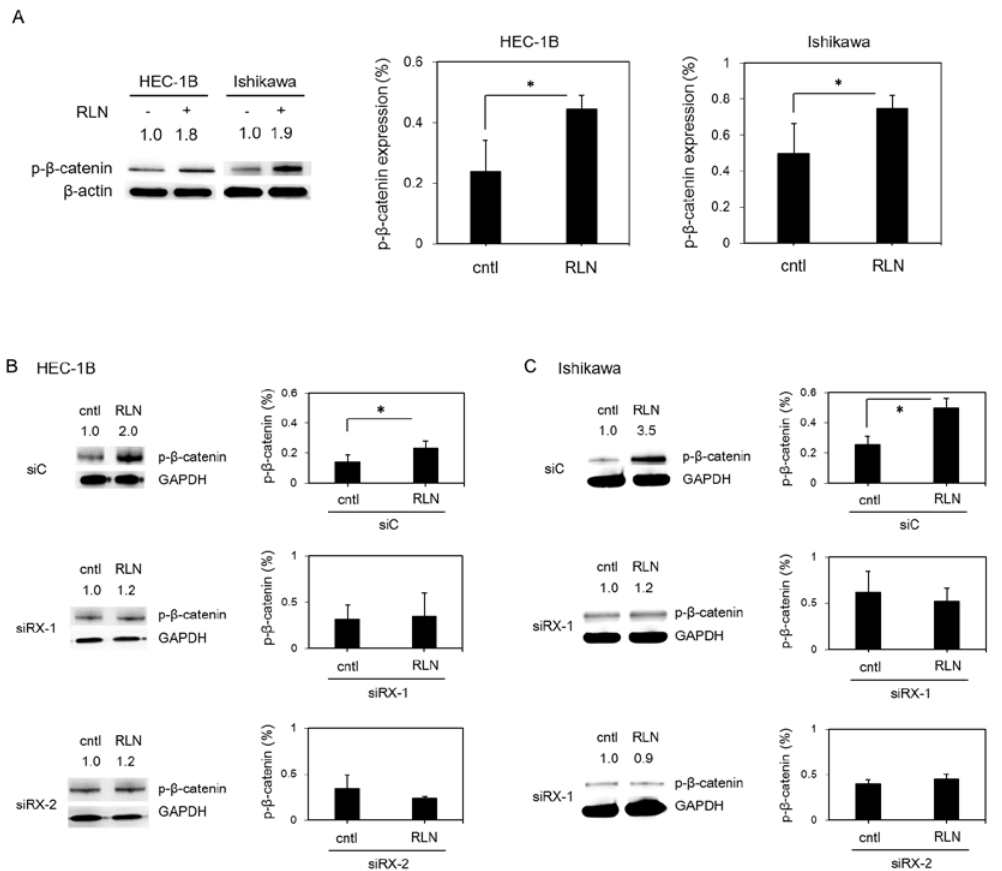
Figure 3. ( A ) The effect of RLN on β -catenin phosphorylation in HEC-1B and Ishikawa cells. Cells were stimulated with RLN for 24 h. ( B , C ) The effect of down-regulated RXFP1 on β -catenin phosphorylation, which was induced by relaxin 2 treatment, in HEC-1B ( B ) and Ishikawa ( C ). Relative intensity values, which have been normalized to the values for the control ( − = 1.0), are shown. The data are expressed as means ± SD of three independent experiments with technical triplicates for each. *, p < 0.05 (Student’s t -test). cntl, vehicle control; RLN, relaxin 2; siC, control siRNA; siRX, RXFP1 siRNA. p- β -catenin, phospho β